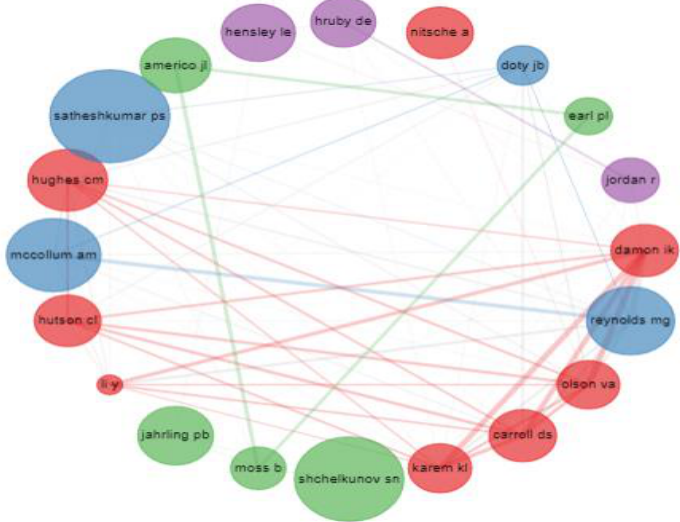
Figure 4. Graphical representation of the collaboration between the authors.